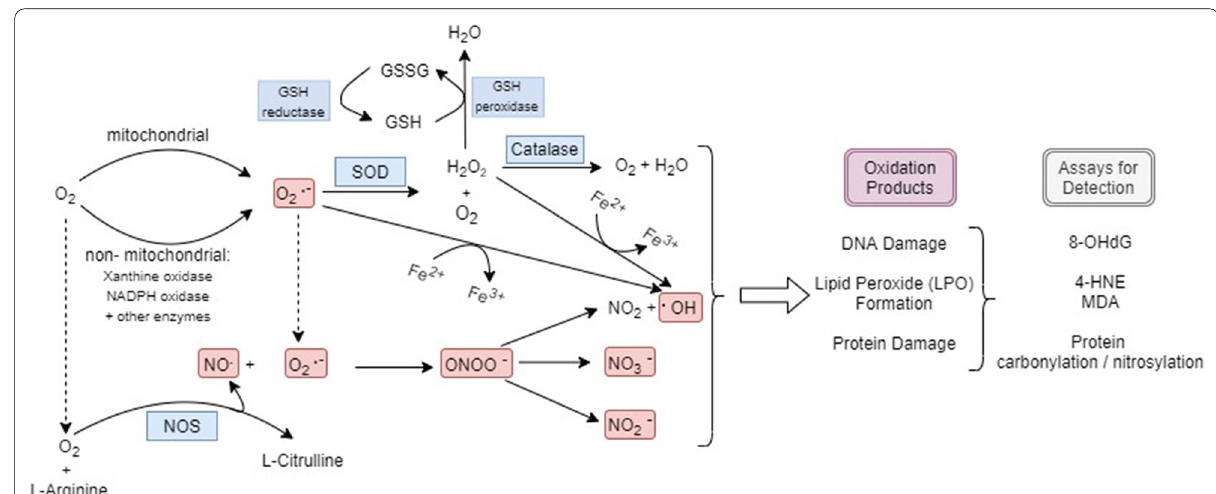
Fig. 6 Diagrammatic representation of major Prooxidant and Antioxidant Pathways as well as the end-products after ischemia–reperfusion injury post-CA. Red represents prooxidants; blue represents antioxidants. 4-HNE, 4-Hydroxyl-2-noneal; 8-OHdG, 8-hydroxy-2’-deoxyguanosine; GSH, glutathione; GSSG, glutathione disulfide; MDA, malondialdehyde; NOS, nitric oxide synthase; SOD, superoxide